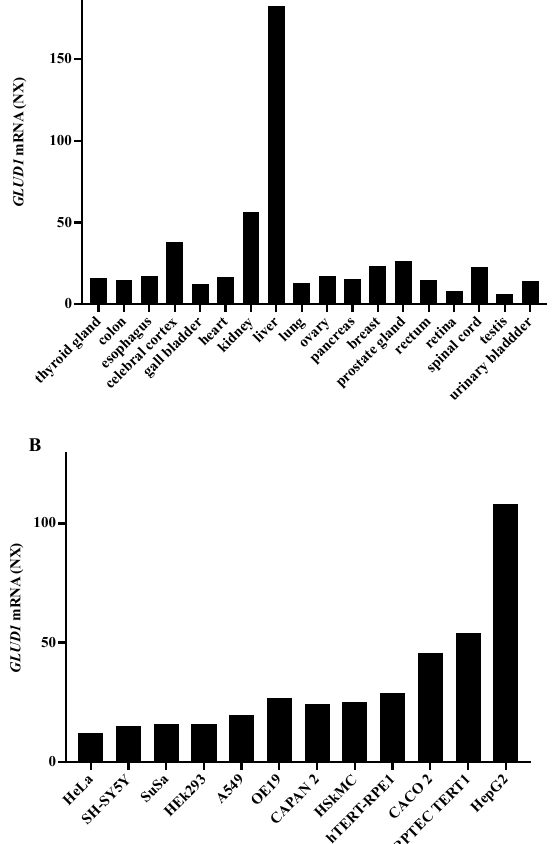
Figure 1. GLUD1 mRNA expression: The analysis of mRNA expression profile of GLUD1 gene in different tissues ( A ) and cell lines ( B ) was obtained by consulting the database Human Protein At- las. The keyword used to start the search was “ GLUD1 ” https://www.proteinatlas.org/ENSG00000148672-GLUD1 (assessed on 18 September 2021). The data relating to the expression in the various tissues shown in A were acquired at this link https://www.proteinatlas.org/ENSG00000148672-GLUD1/celltype (assessed on 18 September